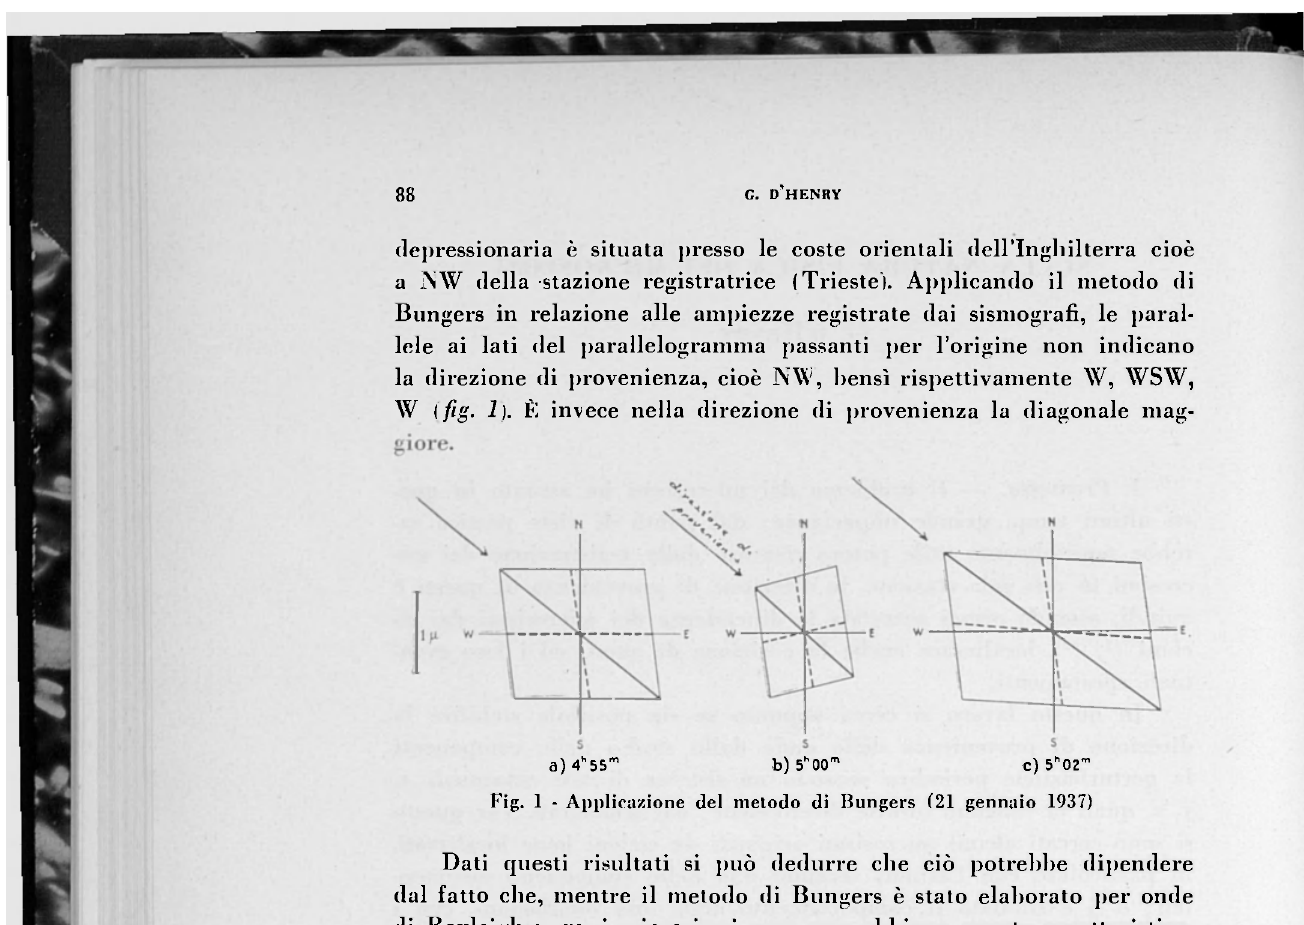
Fig. 1 - Applicazione del metodo di Bungers (21 gennaio